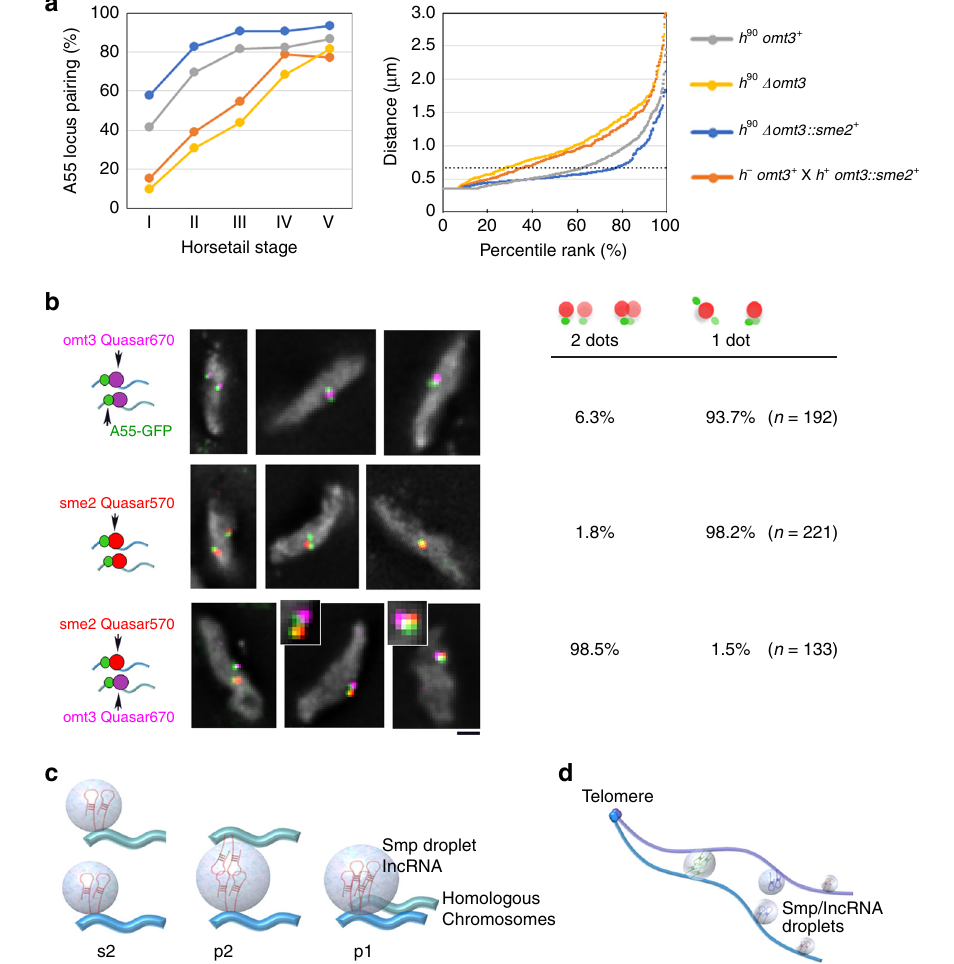
Fig. 6 Speci fi city for the recognition of homologous loci. a Pairing frequency at the A55 locus in h 90 homozygous zygote cells (left panel): wild type (gray), Δ omt3 (yellow), replacement of omt3 with sme2 ( Δ omt3::sme2 + , blue); and in heterozygous zygote cells from a wild type h − omt3 + crossed with a h + Δ omt3::sme2 + strain (orange). Right panel shows percentile rank plots of the distance between the A55 loci in the fi rst three substages. The dotted line at 0.67 μ m on the Y -axis indicates the threshold of pairing. The authentic sme2 gene was deleted in h 90 Δ omt3::sme2 + cells, and in the heterozygous crossed zygote cells. Source data for Fig. 6 are provided as a Source Data fi le 6. b smFISH analysis for omt3 RNA (probes labeled with Quasar ® 670, purple) and sme2 RNA (probes labeled with Quasar ® 570, red) for the strain combinations shown in a . Chromosomal loci were visualized using lacO /LacI-GFP (green). DNA was visualized using DAPI. Typical smFISH images in the horsetail nuclei are shown on the left; the bar represents 1 μ m. On the left column, a summary of two categories of staining is shown: two GFP dots each with an RNA dot, separated from each other by <0.67 μ m; or a paired GFP dot with one RNA dot. Number of horsetail nuclei examined are shown in the parentheses. c Schematic representation of the pairing of homologous loci in this study. Blue lines represent chromosomes and light blue spheres represent RNA bodies containing Smp proteins and lncRNAs. The s2, p2, and p1 states are de fi ned as in Fig. 3. d The model of chromosome pairing. Blue and purple lines represent a set of homologous chromosomes held together at the telomeres. Spheres represent liquid droplets containing Smp proteins and lncRNAs. Arrays of phase-separated Smp/lncRNA droplets align due to telomere clustering. The homologous droplets fuse together upon contact, promoting the pairing of homologous